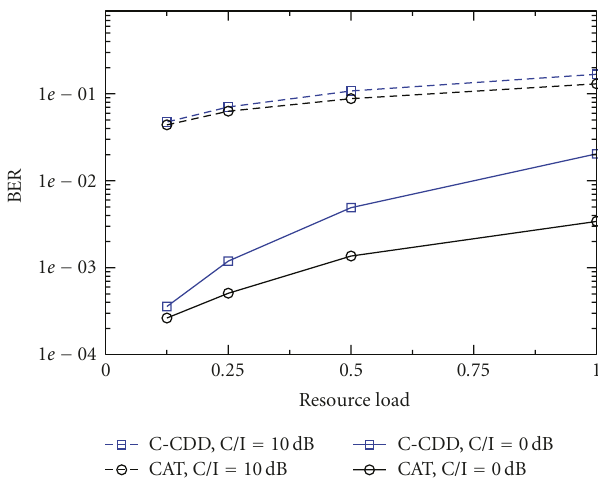
Figure 12: Influence of the MAI to the BER performance for vary- ing resource loads at the cell border and the inner part of the cell.